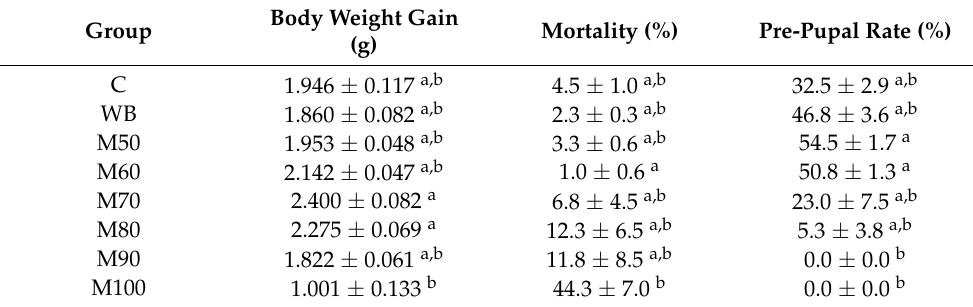
Table 6. Body weight gain, mortality, and pre-pupal rate of BSF larvae in Experiment 2.